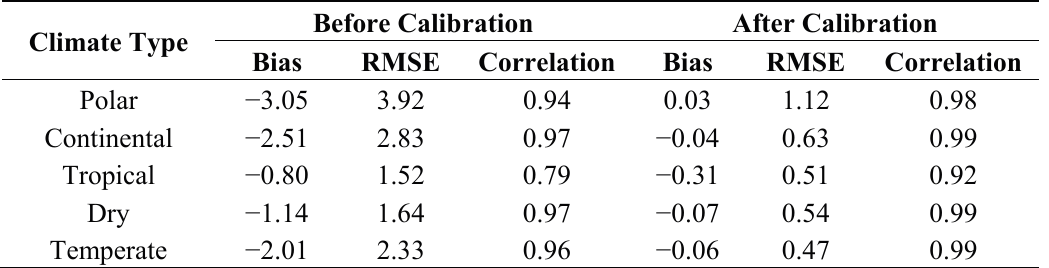
mean biases (Unit: Kelvin), Table 5. Summary of sensor descending (AM) orbit T b Root Mean Square Error (RMSE) differences and Correlation Coefficients across all frequencies and polarizations estimated from overlapping AMSR and MWRI records calibration for five regions representing major Köppen-Geiger global before and after T b climate classification